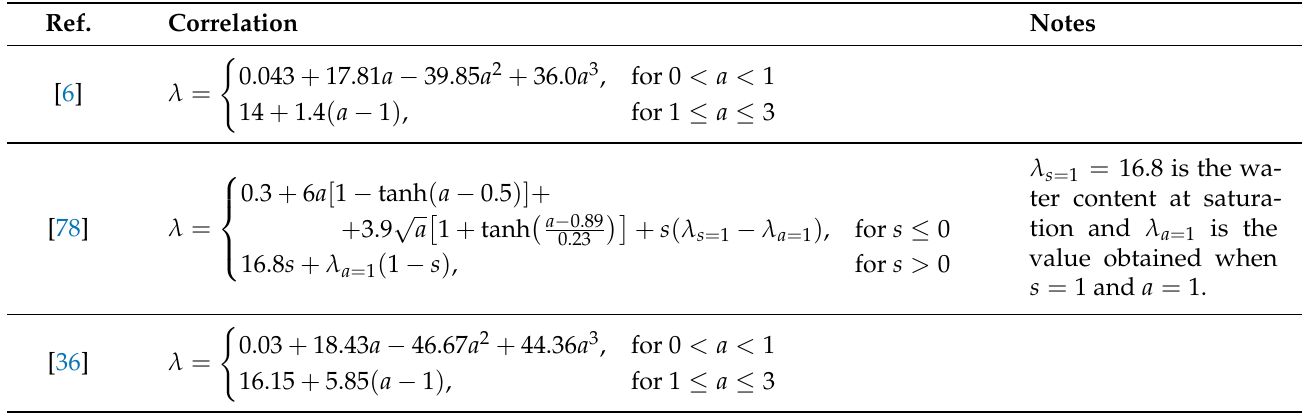
Table 9. Correlations for membrane equilibrium water content λ